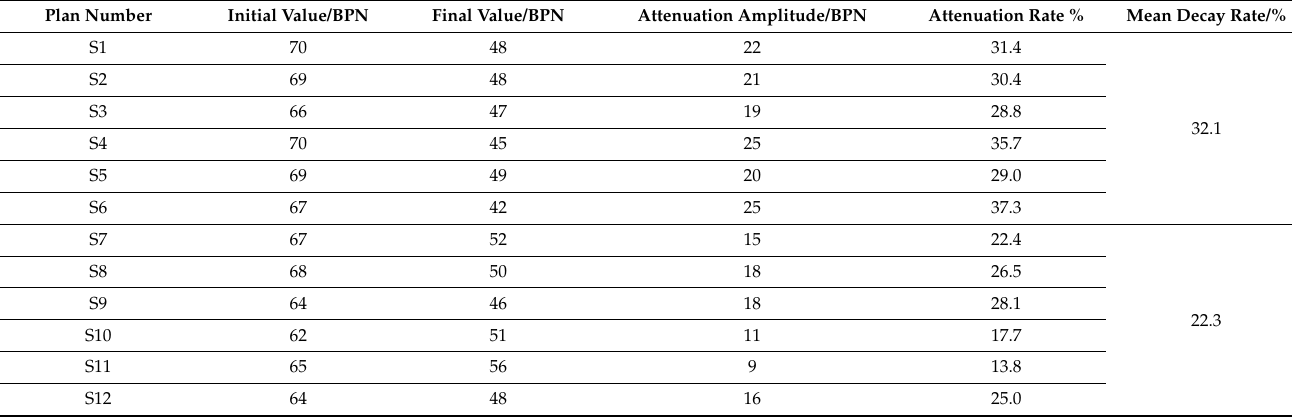
Figure 8. The relationship between BPN and accelerated loading times. Table 5. Friction coefficient of pendulum and load